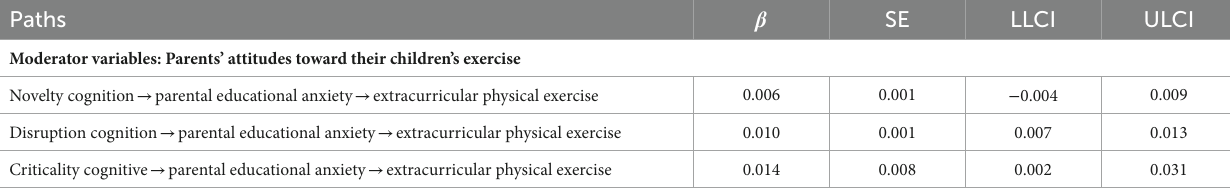
TABLE 5 Mediated moderating effects of parents’ educational